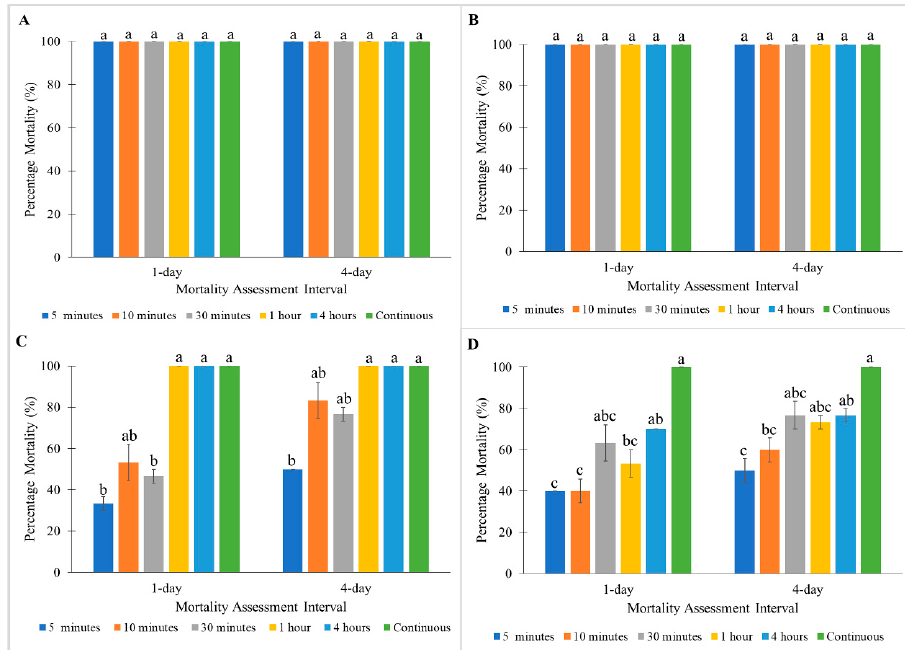
Figure 2. Influence of exposure time on Temprid SC on percentage mortalities of a susceptible C. lectularius strain and three C. hemipterus strains at 1 and 4 days post-treatment. ( A ) Monheim, ( B ) Madam Mo, ( C ) Tanjong Tokong, ( D ) Green Lane strains. Bars with di ff erent letters are significantly di ff erent (Kruskal–Wallis test, p <